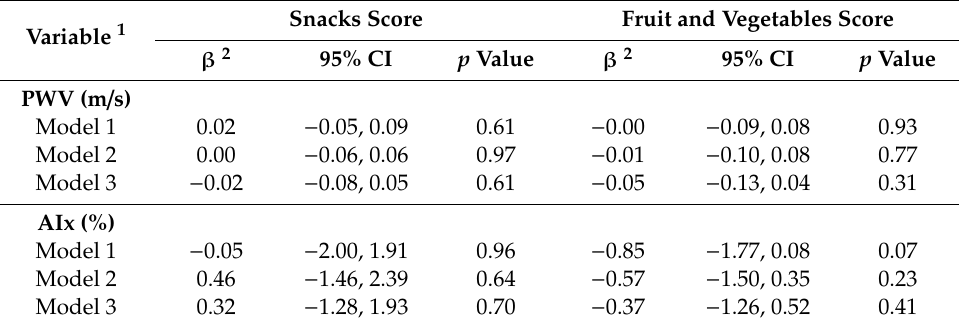
Table 3. Association of dietary pattern scores with PWV ( n = 389) and AIx ( n = 337). Snacks Score Fruit and Vegetables Variable 1